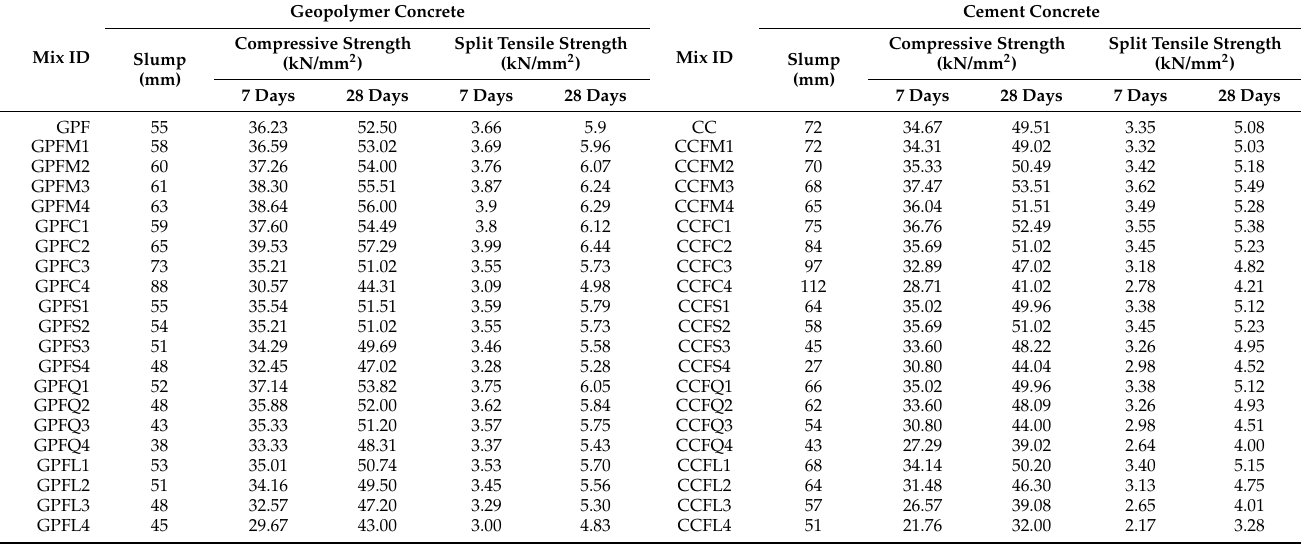
Table 6. The 28-day test results for GPC and CC with various fine aggregates.